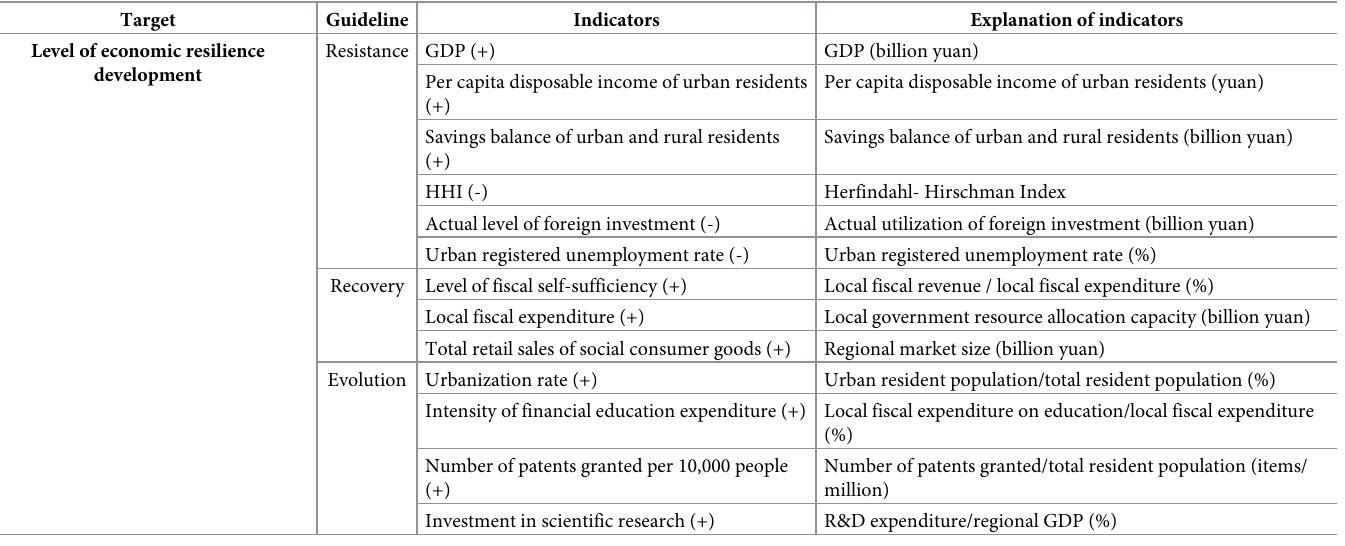
Table 3. Comprehensive evaluation index system of economic